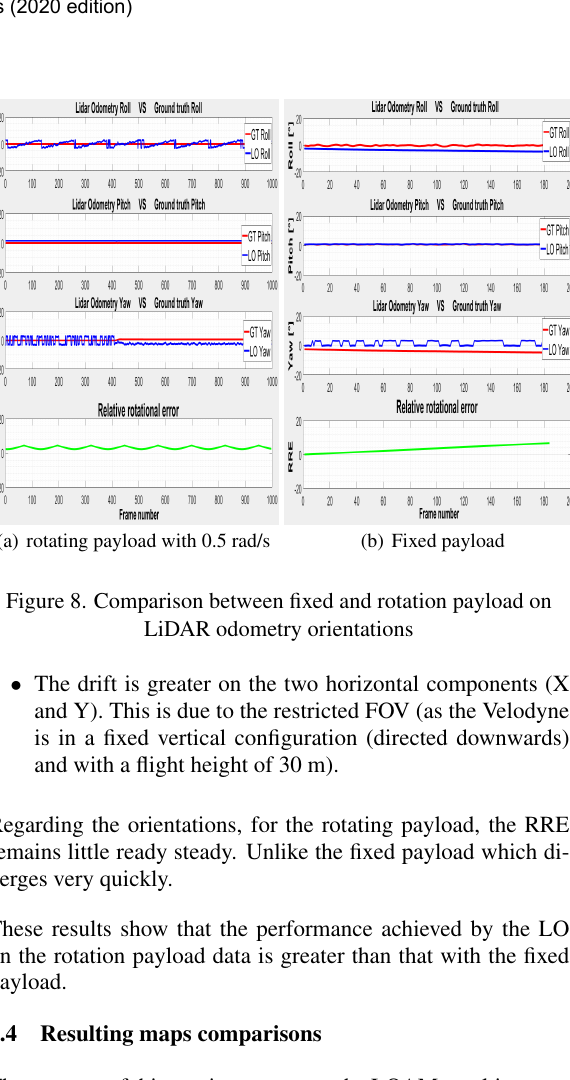
Figure 7. Comparison between fixed and rotation payload on LiDAR odometry positions